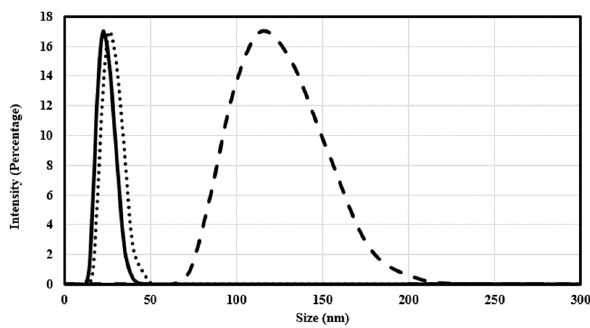
Figure 8. The particle size distribution profile of prismatic silver nanoparticles coated with citrate PVP ( ··· ) and poly-Arg-PVP ( - - ) as determined by dynamic light scattering.